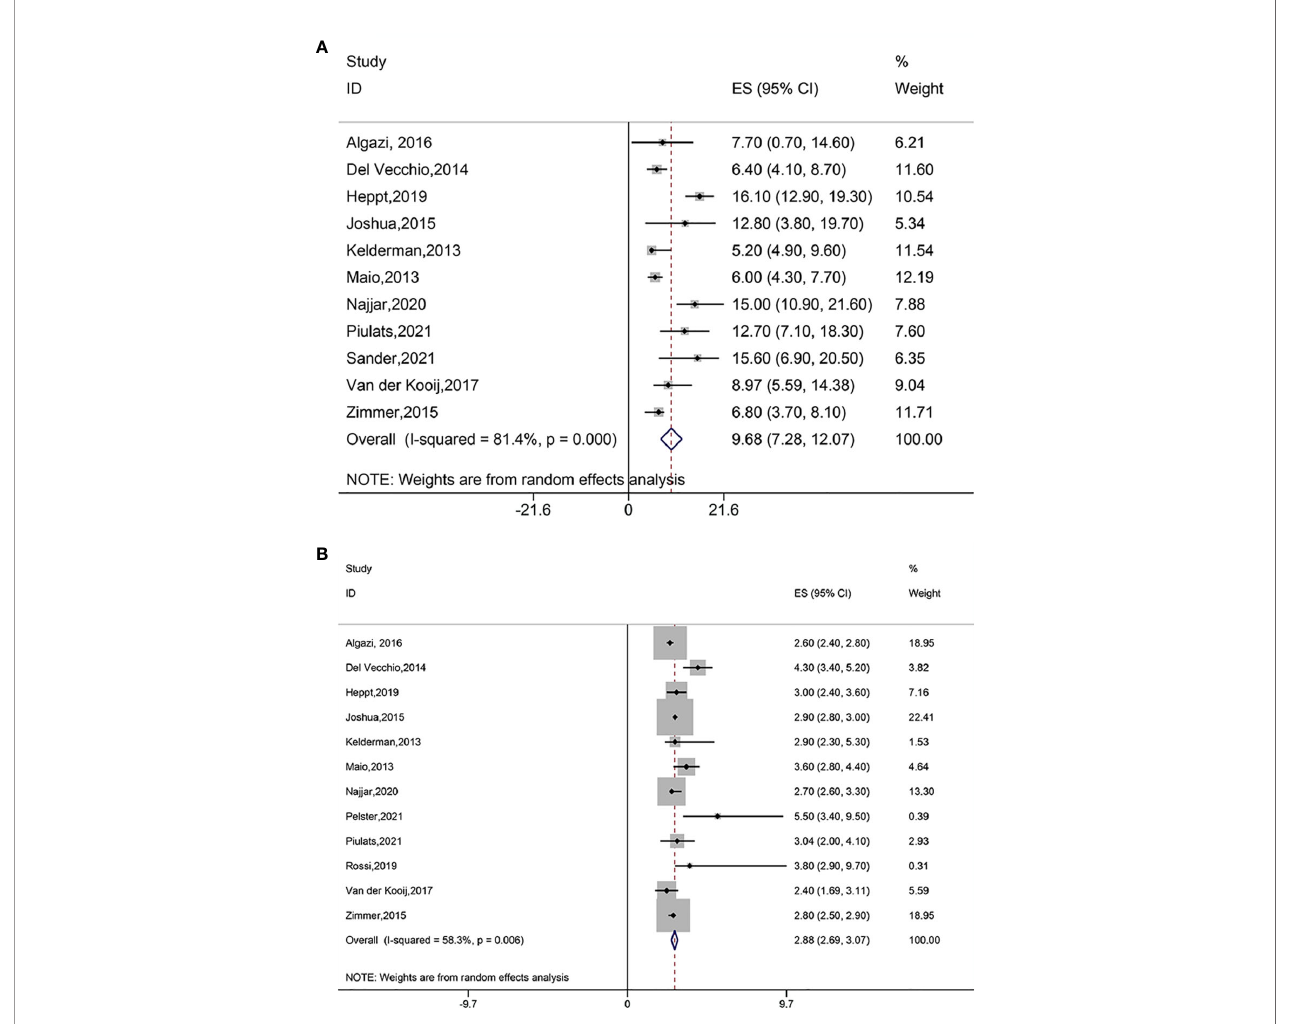
FIGURE 3 | (A) Forest plot of overall survival (OS) of immune checkpoint blockade treatment. (B) Forest plot of progression free survival (PFS) of immune checkpoint blockade